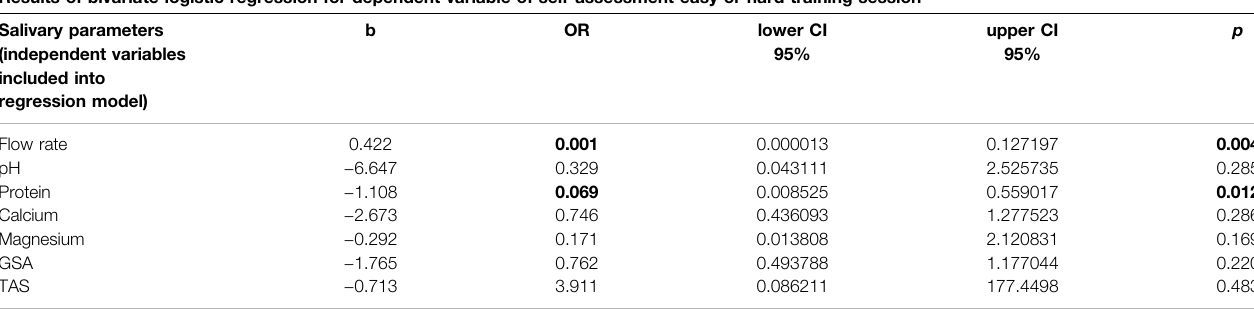
TABLE 3 | Logistic regression analysis for self-assessment of easy or hard training session as dependent variables. Results of bivariate logistic regression for dependent variable of self-assessment easy or hard training session Salivary parameters (independent variables included into regression